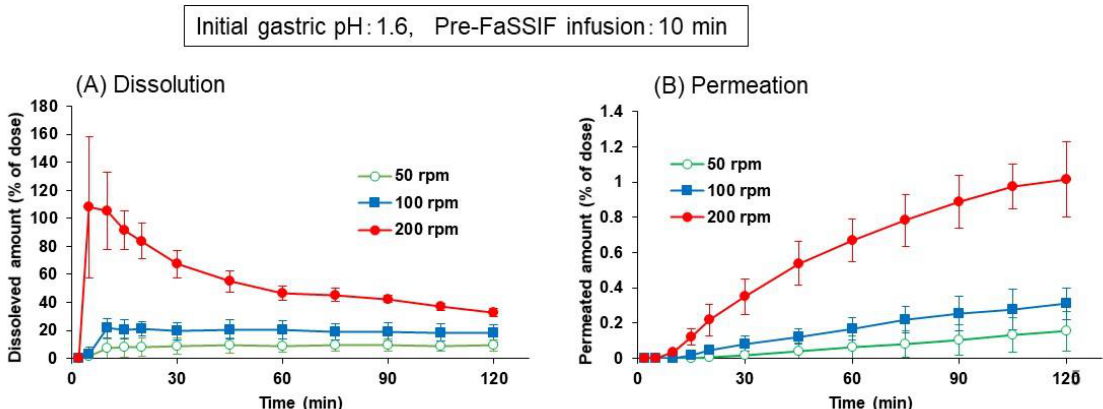
Figure 5. Effect of paddle speed on the dissolution ( A ) and permeation ( B ) time profiles of dipyridamole from Persantin ® tablets 25 mg in the BE checker. Each data point represents mean ± S.D. ( n = 3).